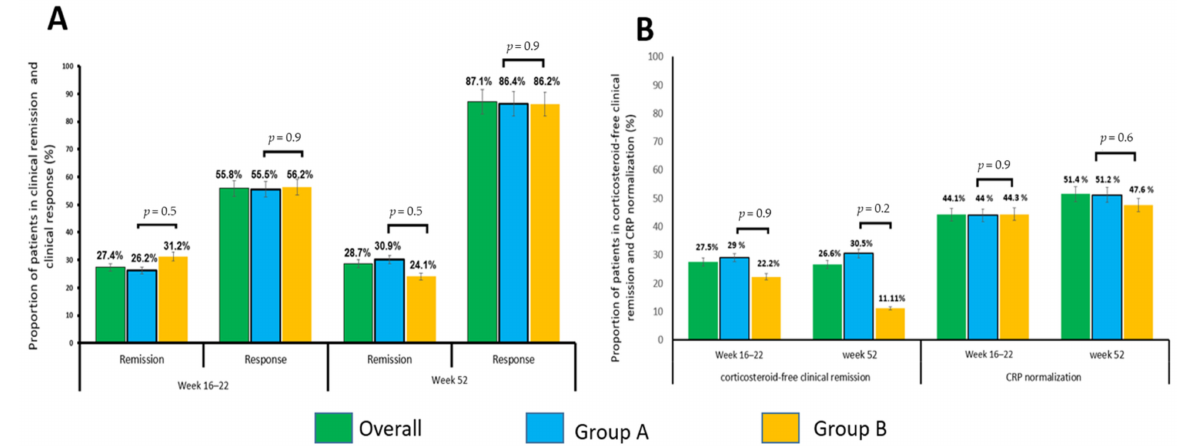
Figure 2. Outcome. ( A ): The proportion of patients achieving clinical remission (HBI ≤ 4) and clinical response (delta HBI ≥ 3) during the study period. ( B ): The proportion of patients achieving corticosteroid-free clinical remission during the study period, and the proportion of patients with CRP normalization (CRP serum concentration levels less than normal range as per cut-off used in the corresponding institutions). CRP, C-reactive protein, HBI: Harvey–Bradshaw